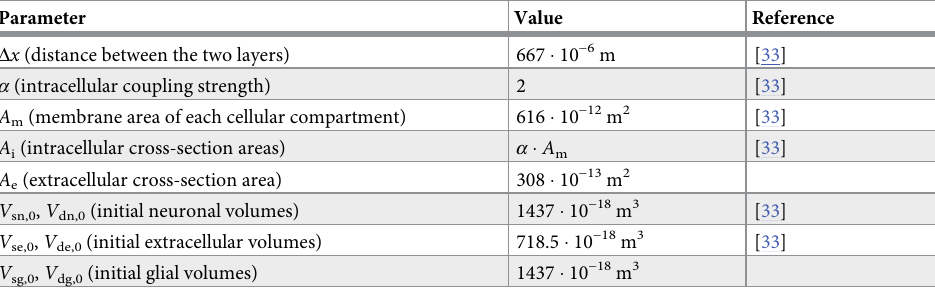
Table 1. Geometrical